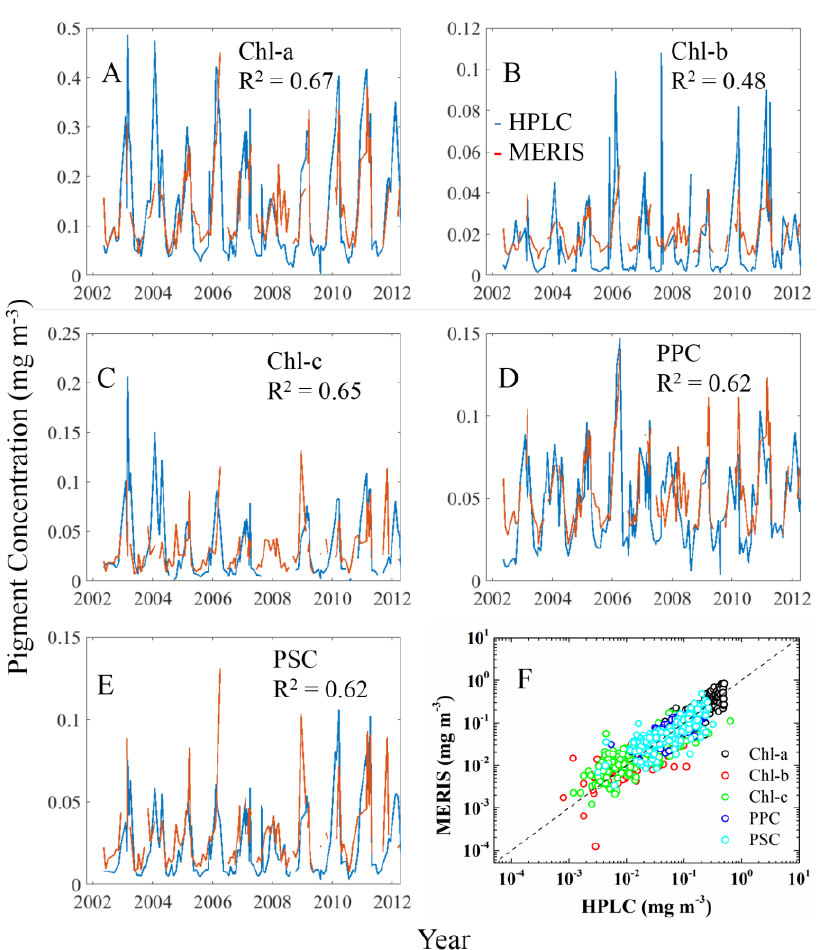
Figure 5. Time series of pigment concentrations from BATS HPLC and MERIS R rs ( λ ), and the determination coefficients (R 2 ). A : Chl-a: chlorophyll a , B : Chl-b: chlorophyll b , C : Chl-c: chlorophyll c , D : PPC: photoprotective carotenoids, E : PSC: photosynthetic carotenoids, F : the scatterplot of estimated versus in situ pigment concentrations.